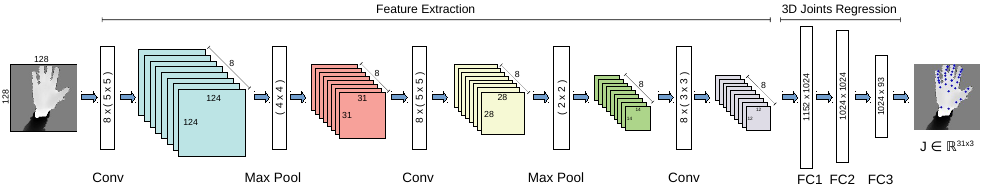
Figure 1. The architecture of Convolutional Neural Network (CNN)-based hand pose estimation algorithm. The CNN takes a 128 × 128 input preprocessed image. It consists of 3 convolution layers each followed by an ReLU activation and max pooling. Afterwards, there are 2 fully connected layers with ReLU activation. A third fully connected layer (joint regression layer) regresses 3D joint positions. Conv stands for a convolution layer. Each conv is followed by a ReLU activation. FC denotes a fully connected layer.